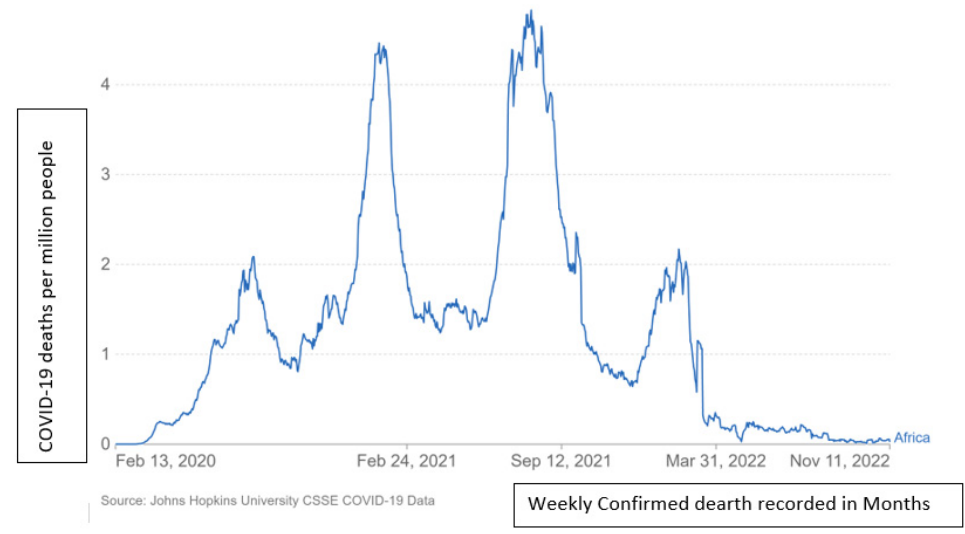
Figure 2. This figure indicates the daily confirmed deaths due to COVID-19 per million people in Africa from February 2020 to November